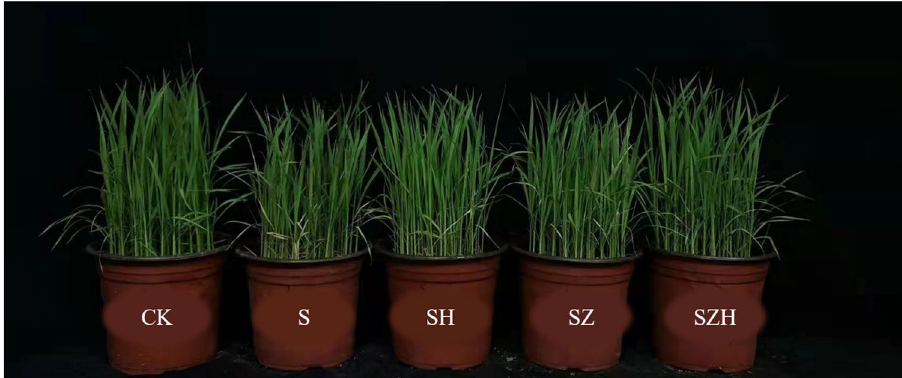
Figure 1. Effects of Hemin on the growth of rice seedlings under NaCl stress (5 d) in HHZ. CK: 0 mM NaCl + 0 μmol·L −1 Hemin, S: 50 mM NaCl + 0 μmol·L −1 Hemin, SH: 50 mM NaCl + 5 μmol·L −1 Hemin, SZ: 50 mM